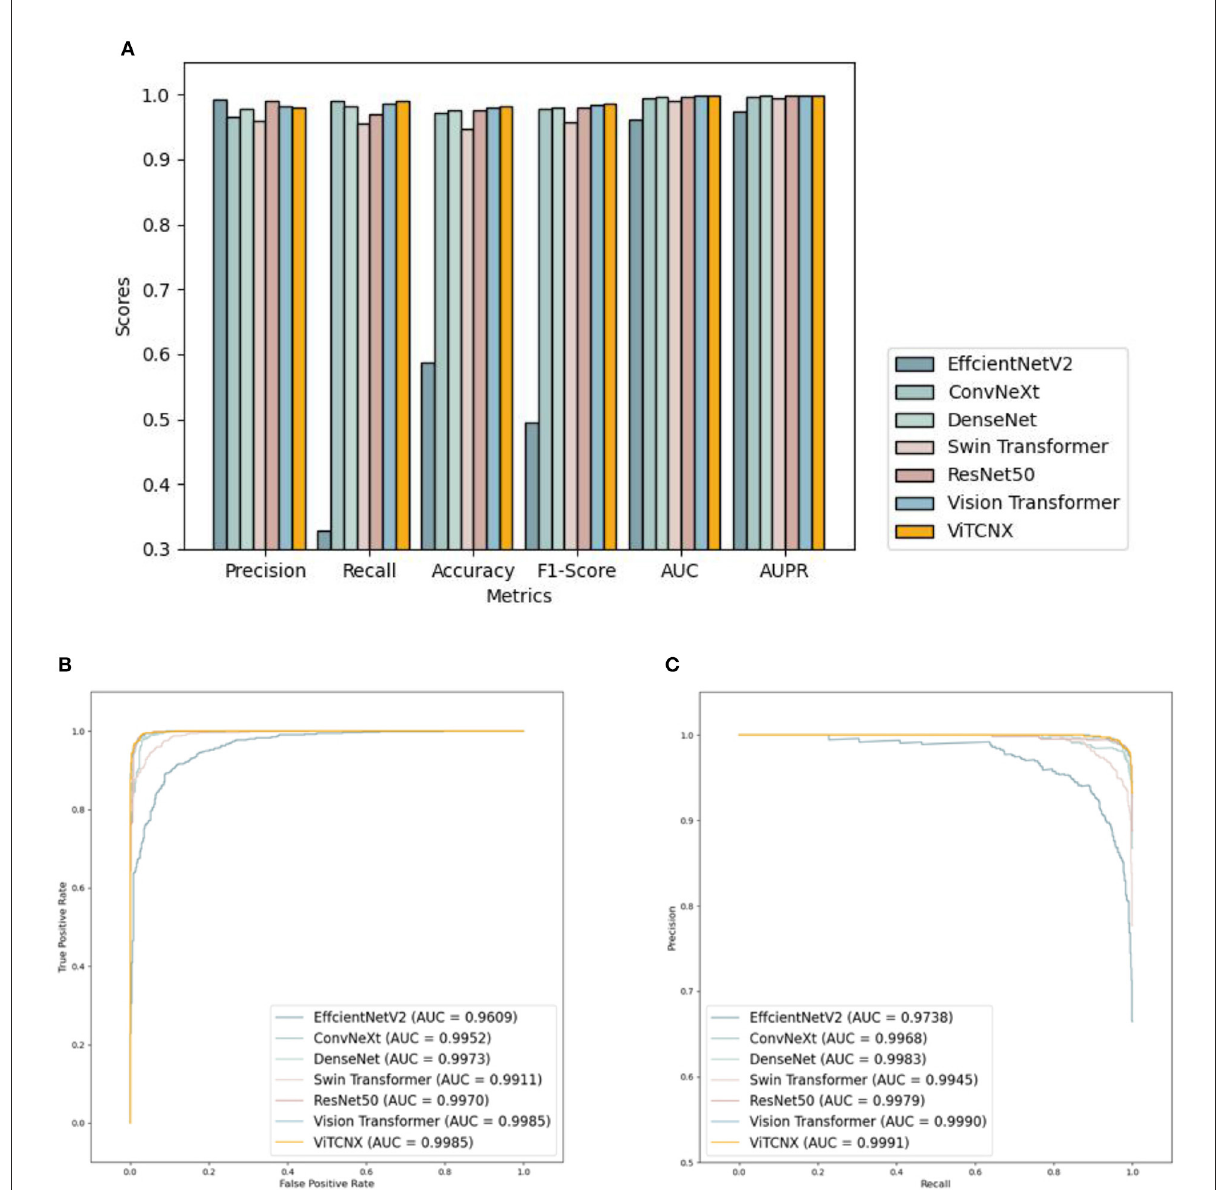
FIGURE7 (A) The performance comparison of VitCNX and six other models for COVID-19 in binary classification problems; (B,C) The AUC and AUPR values of VitCNX and six other models for COVID-19 in binary classification